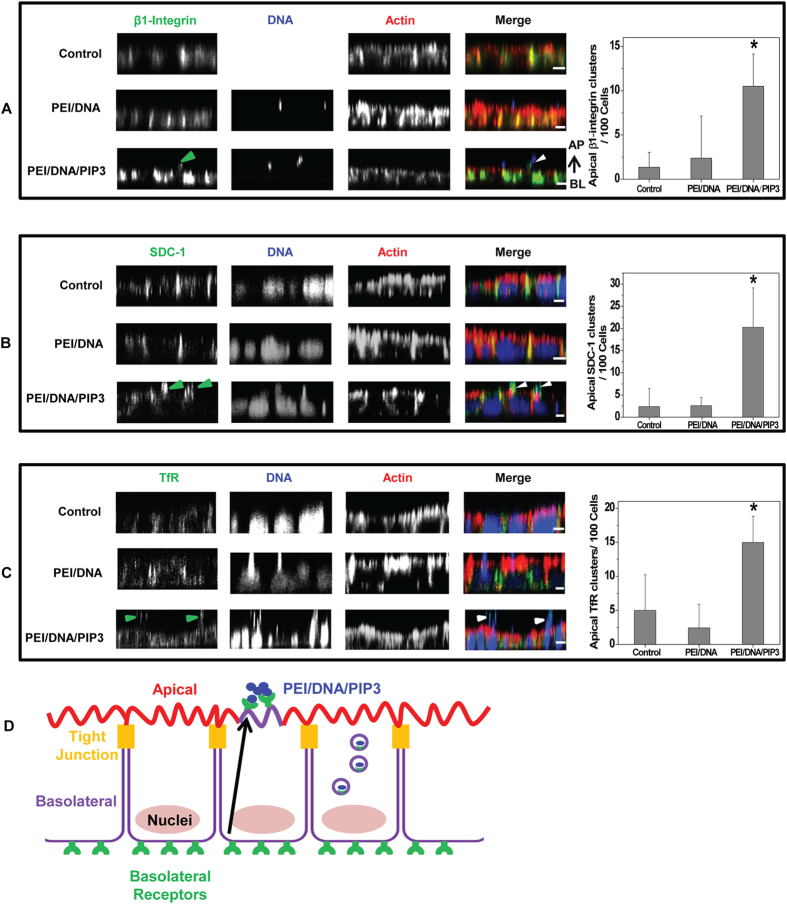
Apical incubation of MDCK cells with PEI/PIP3 polyplexes induces recruitment of basolateral receptors.After apical addition of PEI/DNA/PIP3 or PEI/DNA complex, cells were fixed and immunostained for (A) β1-integrin at 1 hr (green). Plasmid DNA in polyplex was labelled by Cy5 (Blue); (B) syndecan-1 at 1 hr (green); (C) transferrin receptor (TrfR) at 30 min. (green). F-actin was stained with phalloidin-Alexa Fluor 546 (red). Cell nuclei and plasmid DNA were stained with Draq 5 (blue) in (B,C): Large round structures underneath apical plane, as indicated by staining for actin, represent nuclei. Irregular clusters above apical plane represent the complexes. Apical appearance of basolateral receptors, that colocalizes with polyplex, is indicated with arrowheads. Scale bar is 5 μm. The presence of apical clusters of β1-integrin, syndecan-1, and TrfR was quantified from at least two independent experiments; per condition 80–100 cells were analyzed. Data are presented as mean ± SD. Two-tailed t-test was used to determine statistical difference between each treatment group and control. *p = 0.0003 (A) p = 0.013 (B) p = 0.02 (C). The cartoon (D) illustrates basolateral receptor recruitment by PEI/DNA/PIP3 in MDCK cells.